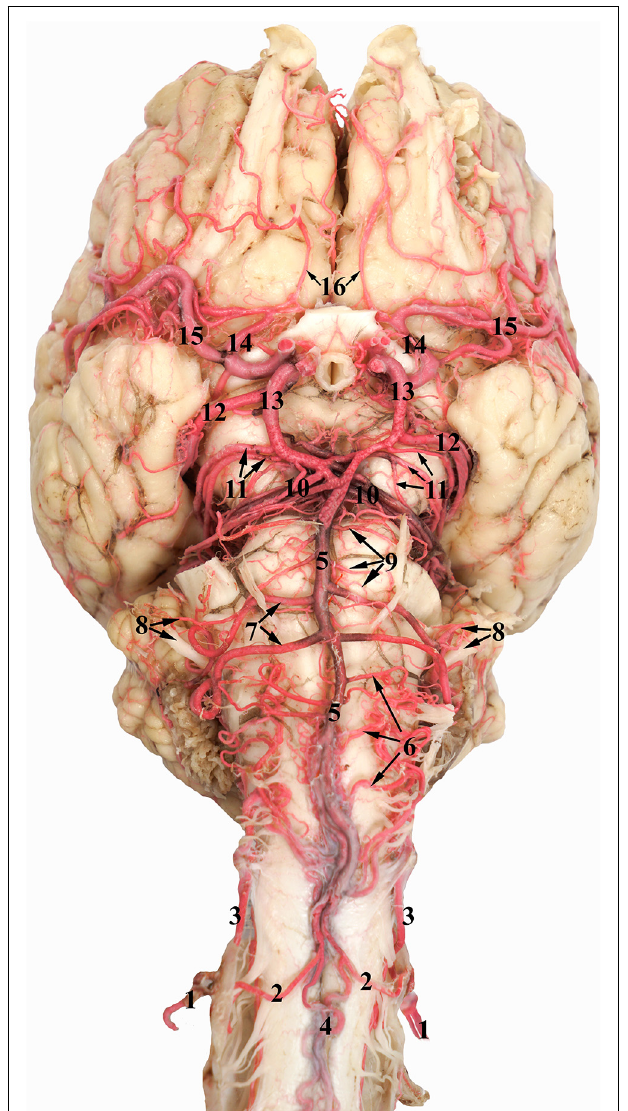
FIGURE 6 | Ventral view of the dromedary brain. 1, Vertebral artery; 2, medial branch of the vertebral artery; 3, lateral branch of the vertebral artery; 4, ventral spinal artery; 5, basilar artery; 6, medullary branches of the basilar artery; 7, caudal cerebellar artery; 8, labyrinthine artery accompanied by the vestibulo-cochlear nerve; 9, pontine branches of the basilar artery; 10, rostral cerebellar artery; 11, caudal choroidal artery; 12, caudal cerebral artery; 13, caudal communicating artery; 14, rostral cerebral artery; 15, middle cerebral artery; and 16 internal ethmoidal